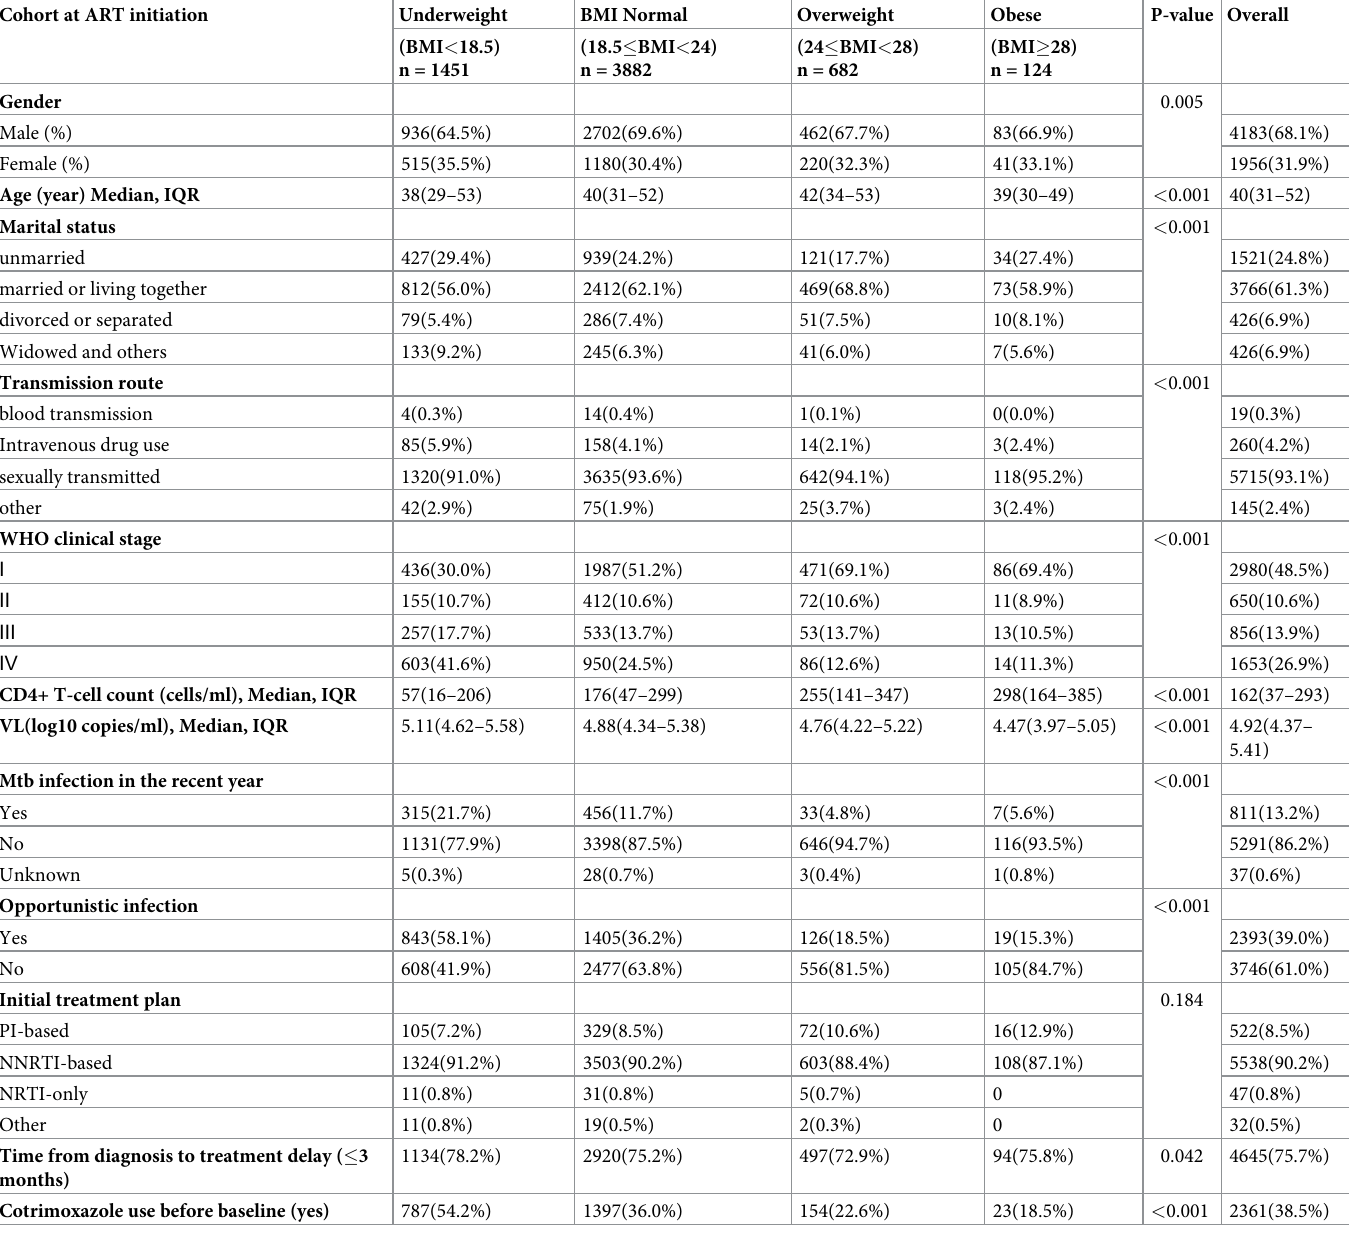
Table 1. Demographic characteristics of HIV patients receiving ART by BMI